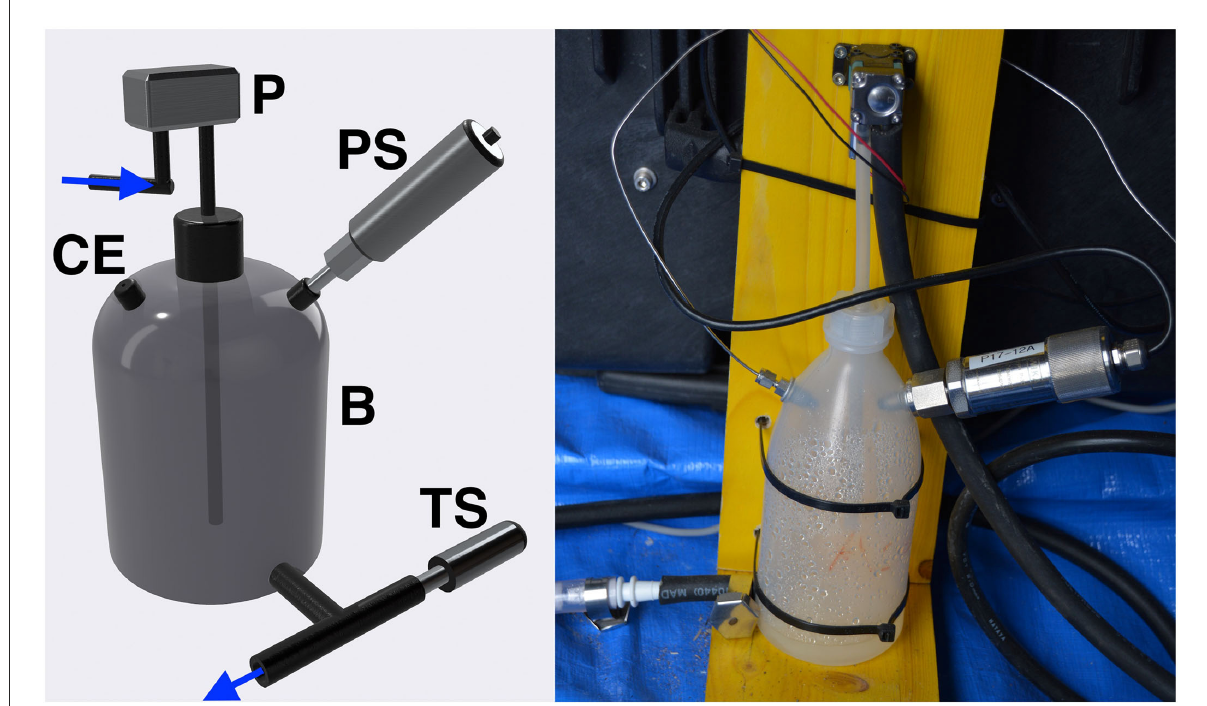
FIGURE2 Sampling bottle for fluid temperatures superior to 65 ◦ C. A membrane pump (P) pumps the hot fluids (e.g., water vapor) into the bottle (B). Two sensors measure the temperature (TS) and the pressure (PS) of the pumped gas. A capillary entry (CE) allows to measure the gases using the miniRUEDI. As incoming gases and condensed water vapor are forced into the bottle near the bottom, condensation-related clogging of the analysis system is avoided because the gas analyzer inlet is located on the upper side of the